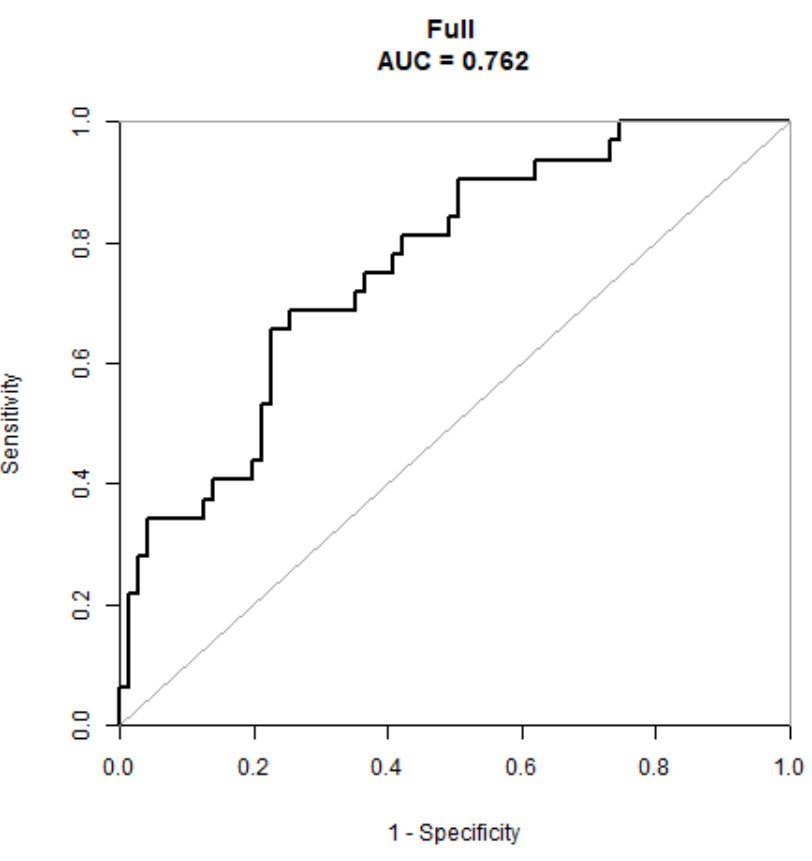
Figure 4. A receiver operating characteristic curve to evaluate the discriminating capability of the nomogram.